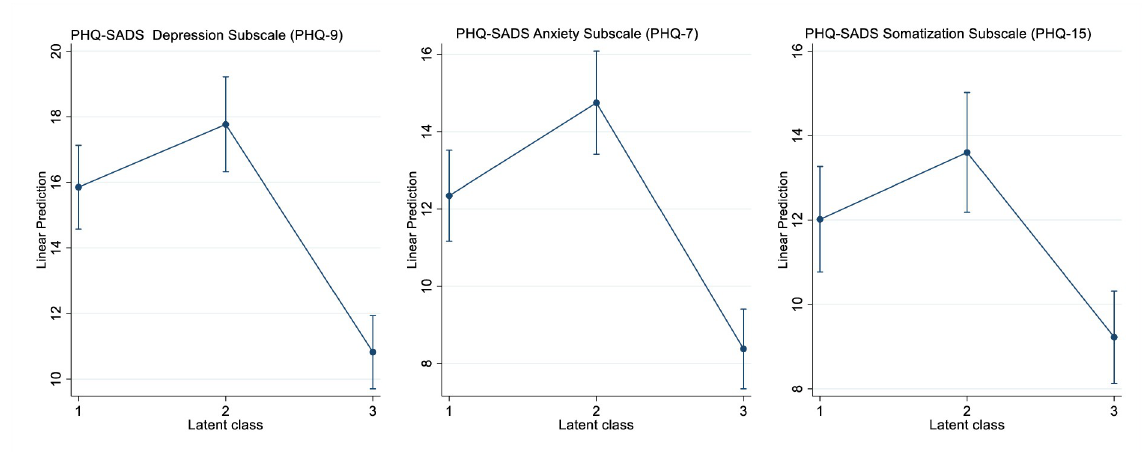
Fig 2. Patient Health Questionnaire (PHQ-SADS) subscales by latent class assignment. Means and 95% confidence intervals adjusted for age, partner, children, higher education, unemployment, bluecollar worker, income, duration of illness, duration of untreated illness, recruitment